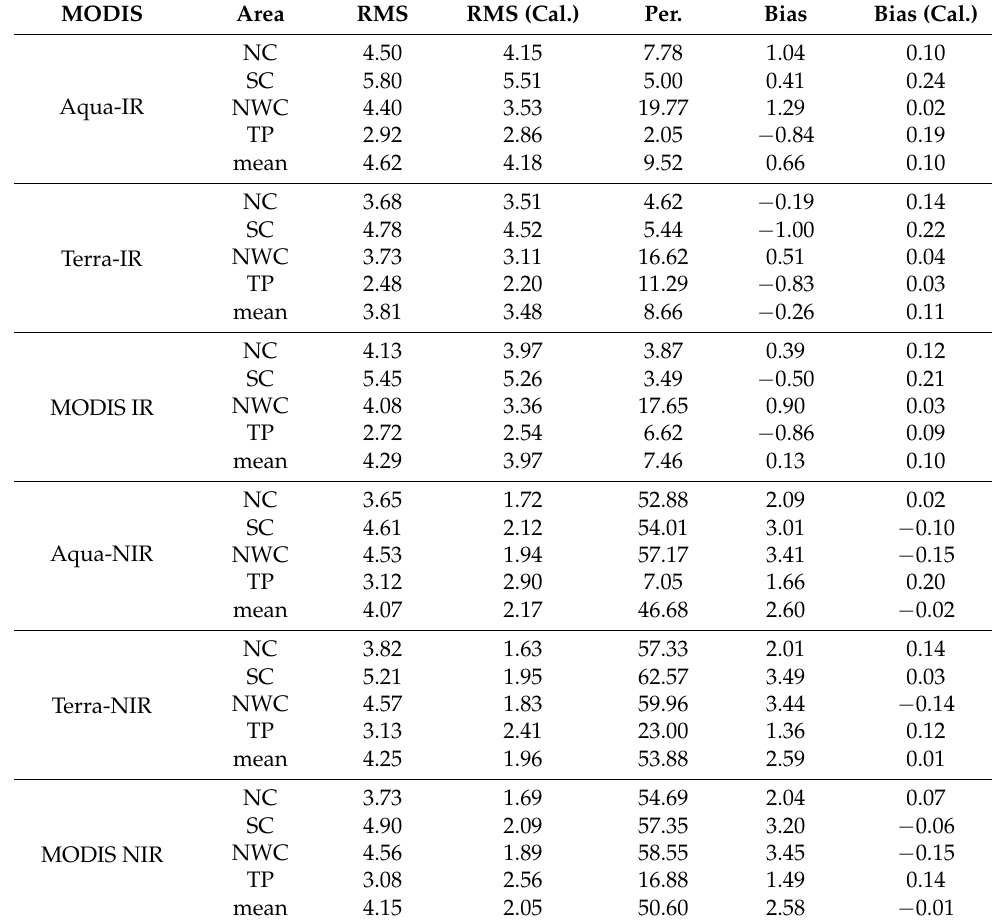
Table 7. Statistical result of RMSE and bias derived from MODIS IR/NIR PWV products with and without calibration using GNSS PWV derived from [39], where Per. refers to the improved percentage of RMSE after calibration. MODIS Area RMS RMS (Cal.) Per. Bias Bias (Cal.)